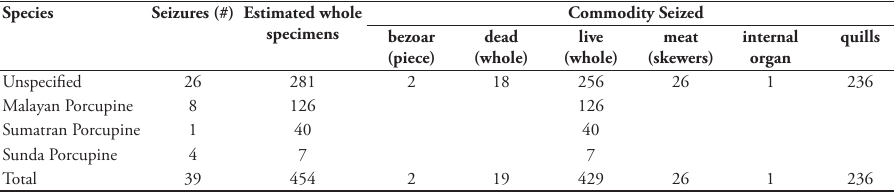
Table 1. Porcupine commodities seized per species from January 2013 to June 2020 and quantities seized in